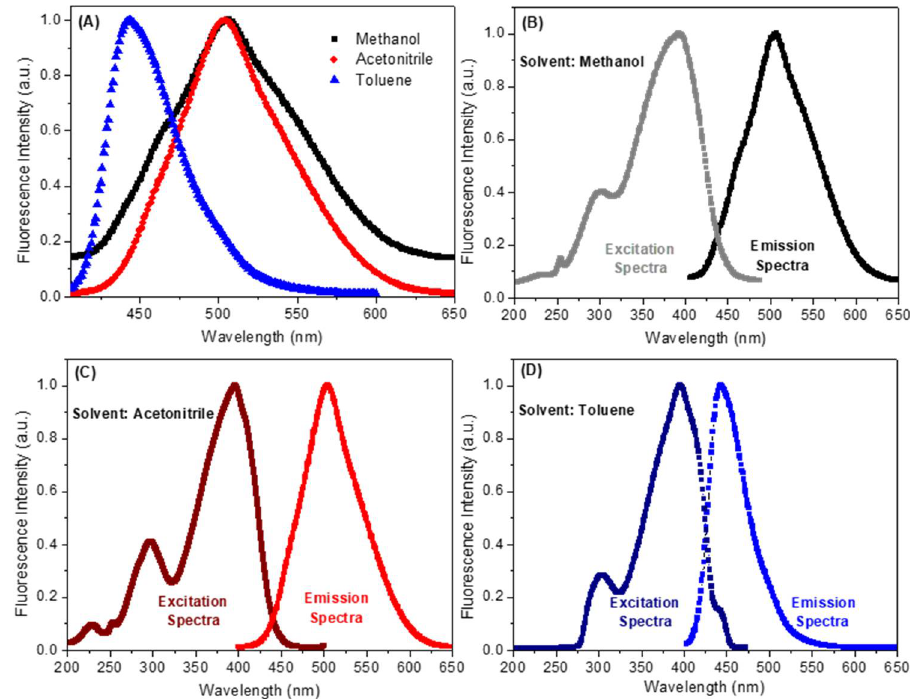
Figure 3. ( A ) Normalized steady-state fluorescence emission spectra for the compound 7 in three different solvents ( λ exc = 390 nm and [ 7 ] = 2.32 × 10 − 6 mol/L). ( B – D ) Normalized steady-state and excitation spectra for the compound 7 in methanol, acetonitrile and toluene, respectively.